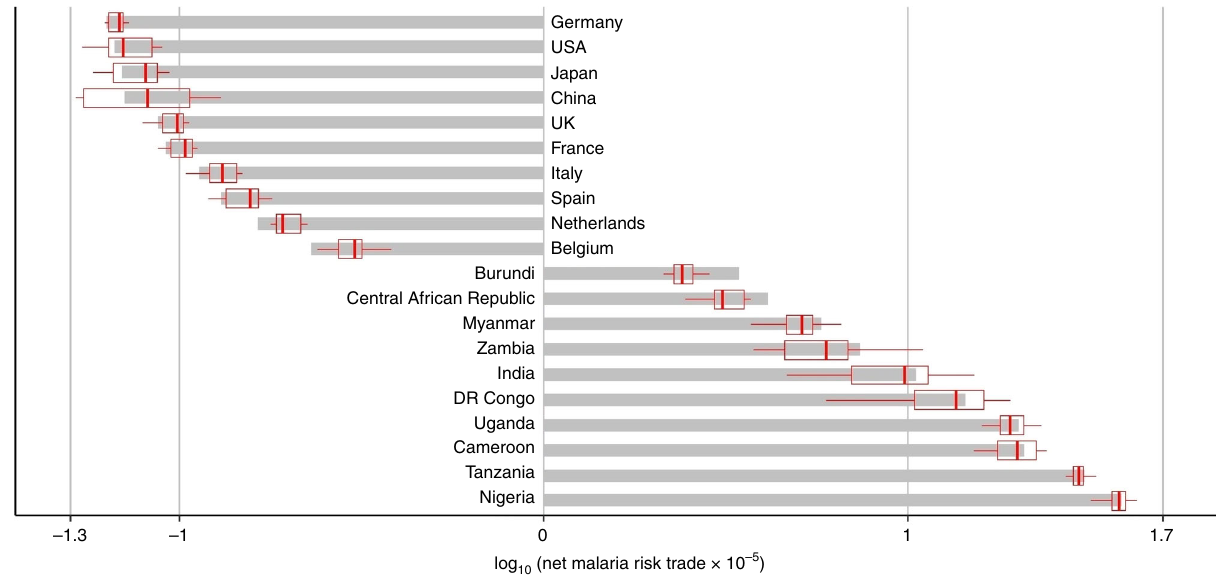
Fig. 2 Net malaria risk trade, negative for net importers, and positive for net exporters. The grey bars and the red bold line represent the median and mean, the red box the standard deviation, and the horizontal red thin lines the minimum and maximum of net malaria risk trade over the 2000 – 2015